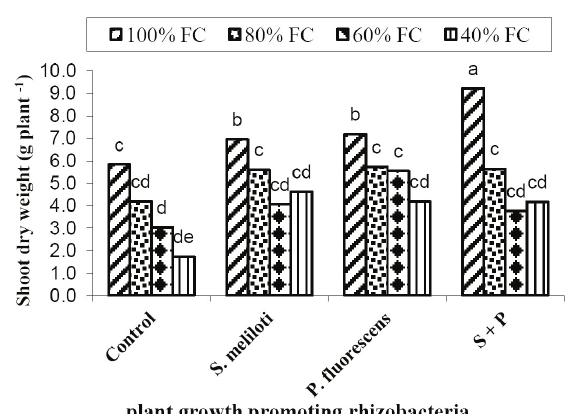
fig. 1 - Interaction of PGPR and soil water content on leaf area of fenugreek.